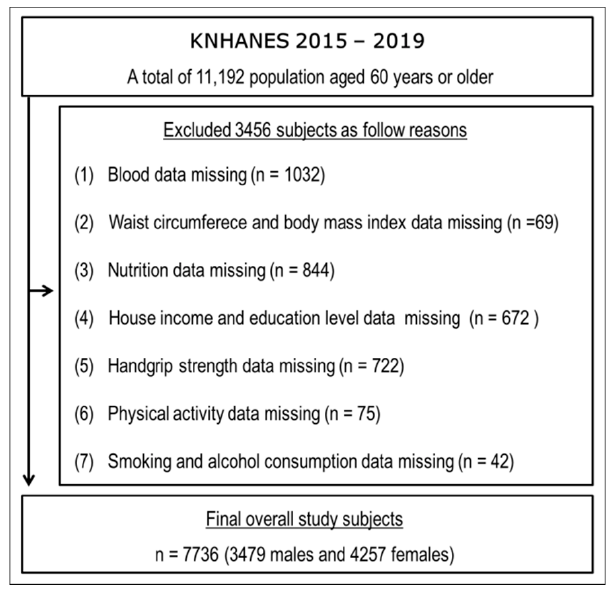
Figure 1. Flow chart of study subjects.